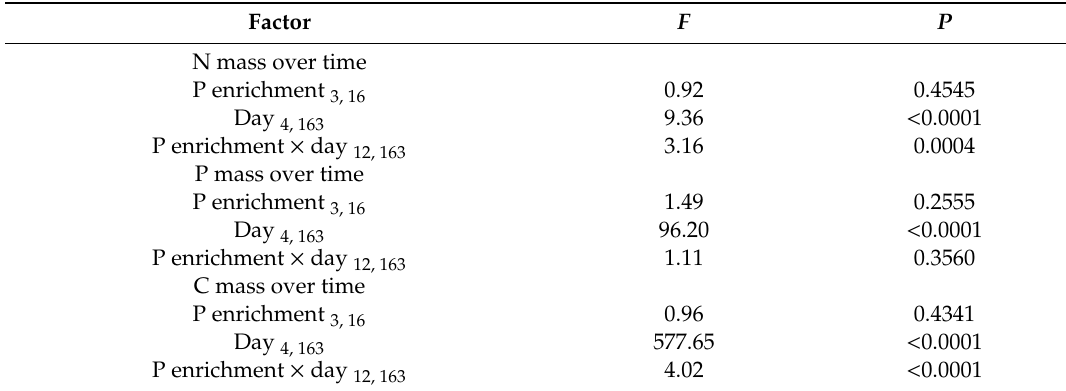
Table 3. E ff ects of P enrichment and day on plant litter N, P and C mass. F values and associated P values are based on linear mixed-e ff ect models that incorporated random e ff ects to account for repeated measures within each mesocosm.